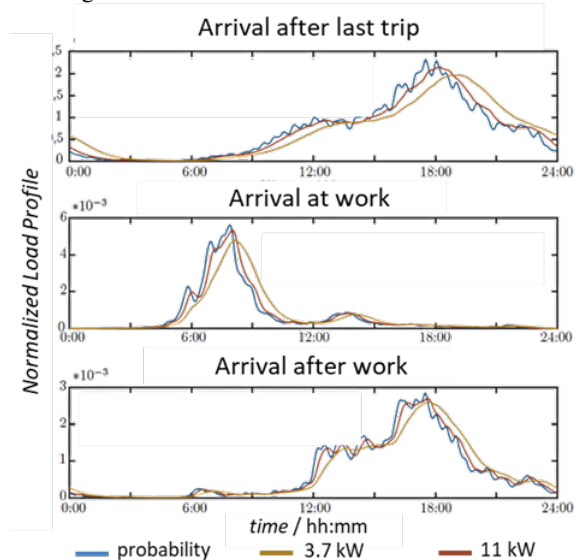
Fig. 5. Probability density functions of arrival